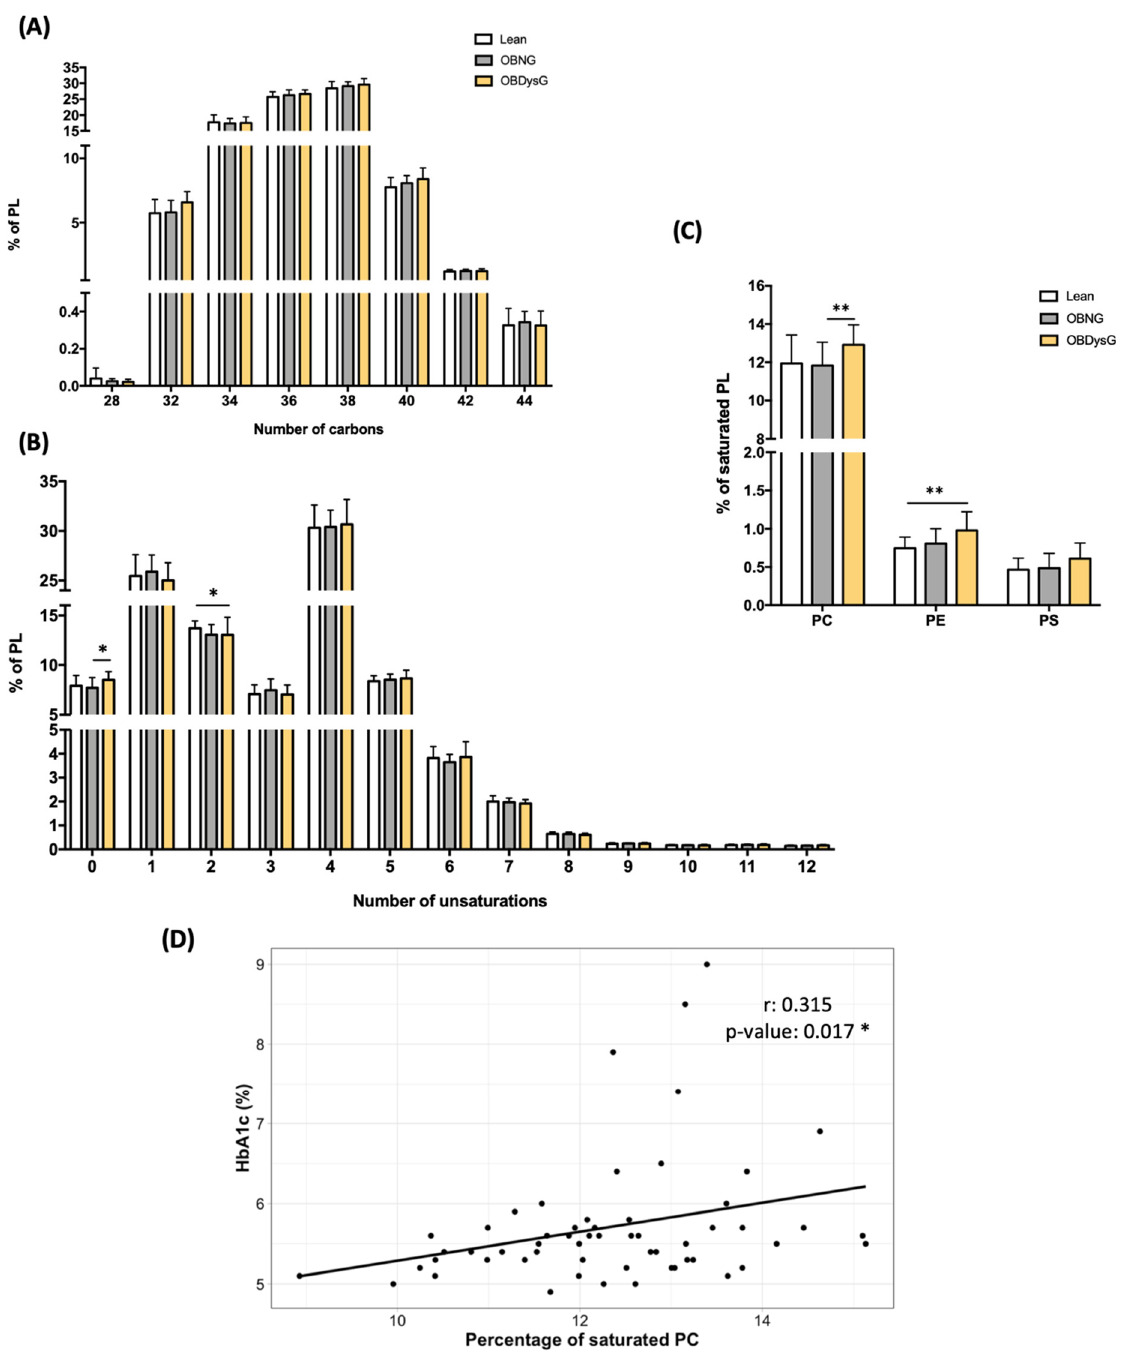
Figure 6. The percentage of saturated PC is increased in PBMCs from OBDysG compared to OBNG patients. Relative abundance of the PL species (PC + PE + PI + PS) comprised of ( A ) the same number of carbons or ( B ) the same number of unsaturation in their hydrocarbon chain and ( C ) relative abundance of saturated PC, PE or PS. Data are mean ± SD. Kruskall–Wallis test, Dunn’s multiple comparison test, * p < 0.05; ** p < 0.01. ( D ) Correlation between HbA1c (%) and percentage of saturated PC. n = 54, r = Spearman’s rank correlation coefficient.